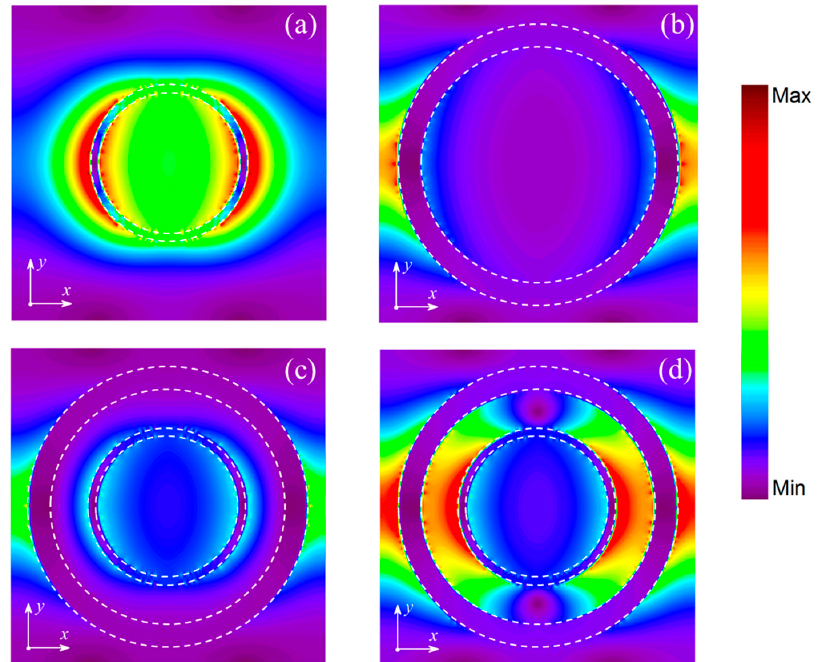
Figure 4. The electric field distributions at ( a ) 51.9 THz when the structure of graphene is individual IR, ( b ) 45.4 THz when the structure of graphene is individual OR. The electric field distributions at ( c ) 55.4 THz, ( d ) 39.1 THz when the structure of graphene is CDR.